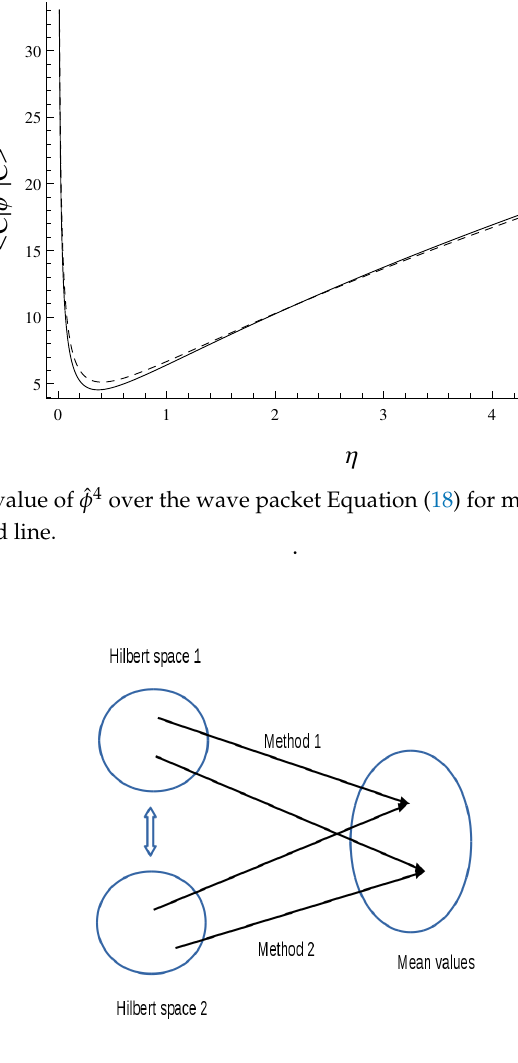
Figure 3. The illustration that different methods could have different Hilbert spaces for producing the same set of the mean values for the arbitrarily given operators. Still, there should be correspondence between the state C ( k ) of the Hilbert space 1 and the state ˜ C ( k ) of the Hilbert space 2 producing the same mean values.